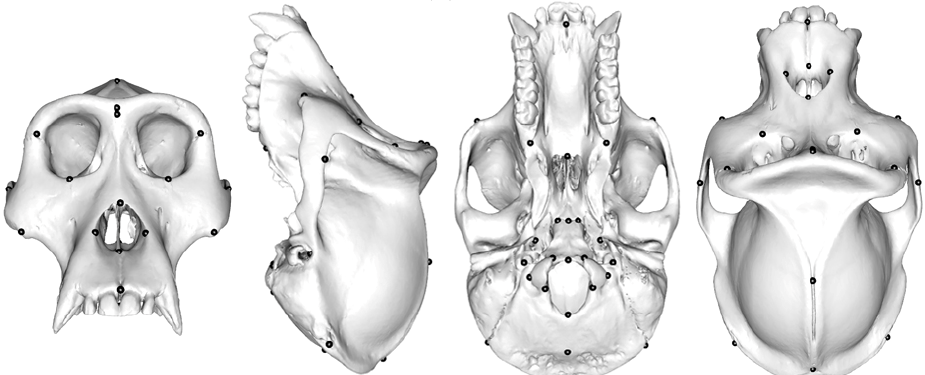
Figure 1. Ape cranial dataset: an ape cranium with 41 anatomical